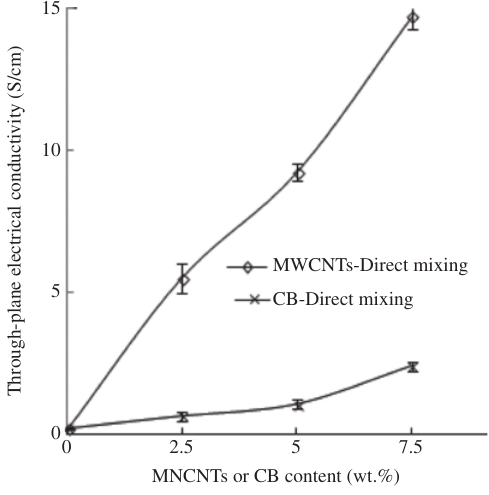
Figure 4: The effect of the MWCNTs and CB on the through-plane electrical conductivities of the PP/SG/xGnP composites.